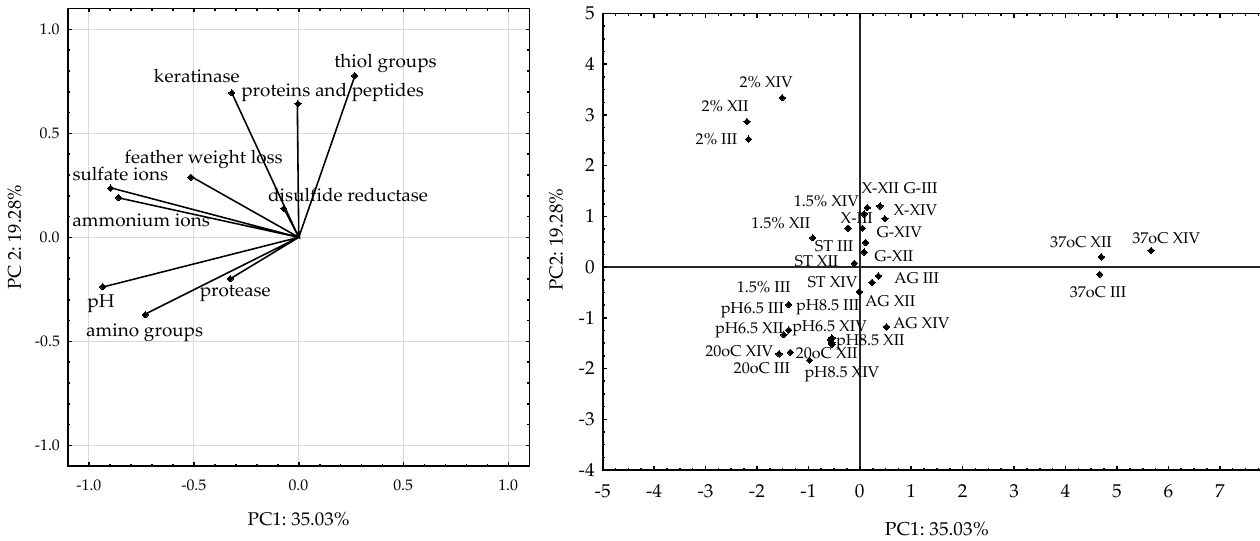
Figure 6. PCA loading plot and score plot demonstrating relationships between fungal keratinolysis indicators, i.e., enzymatic activity, concentration of soluble proteins, peptides, amino acids, ammo- nium and sulfate ions, as well as feather weight loss, different culture conditions, and medium composition in Trichophyton ajelloi